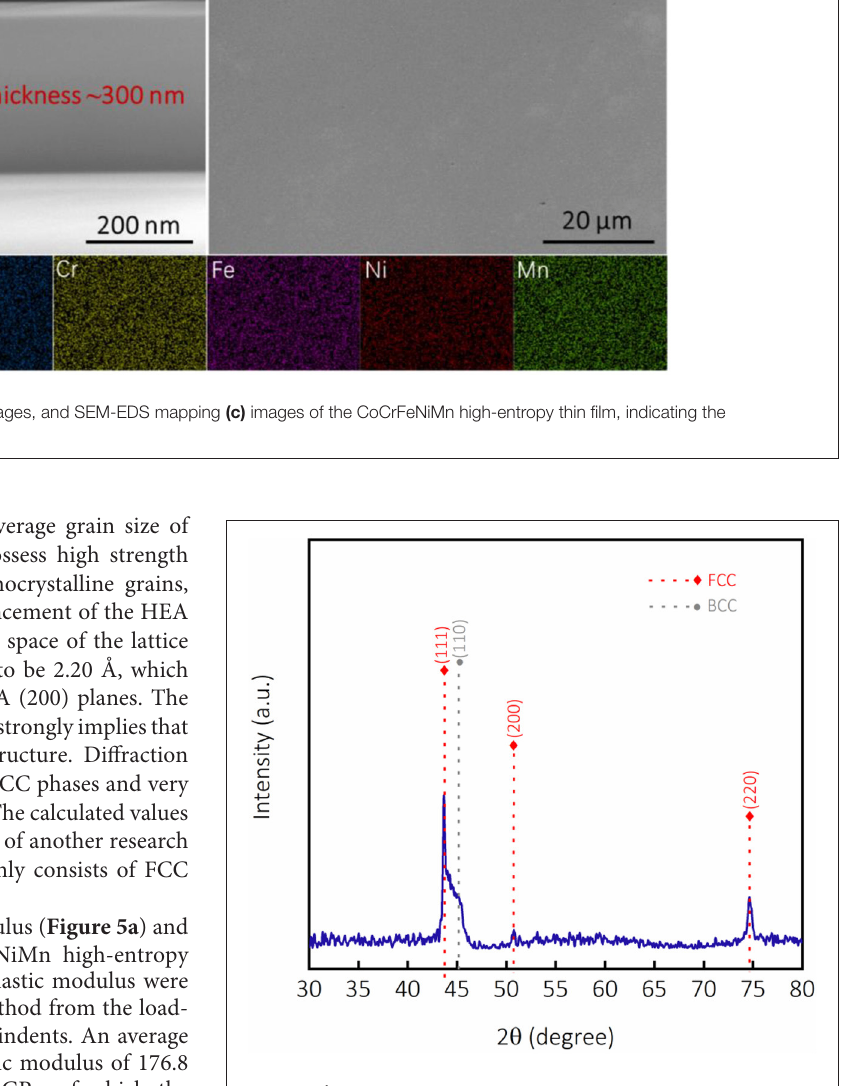
FIGURE 3 | XRD pattern obtained from the CoCrFeNiMn high-entropy thin